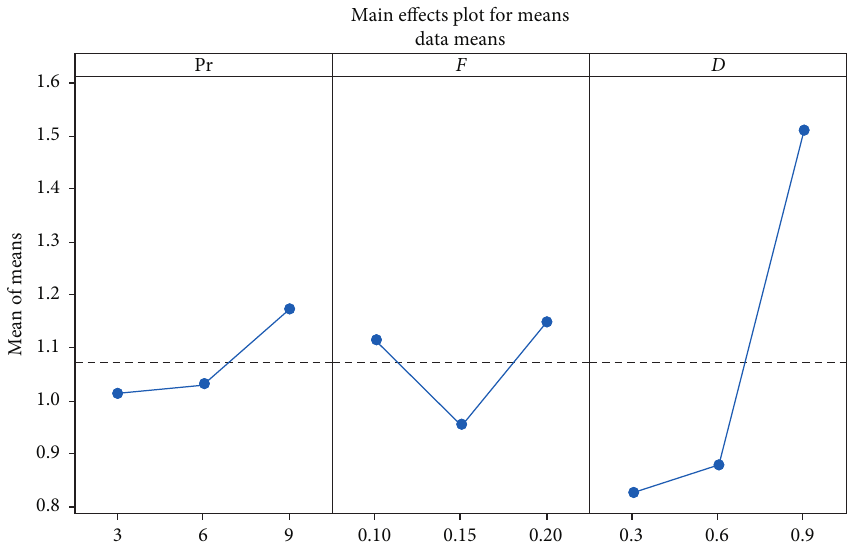
Figure 3: Mean-based important effect diagram for wear on the tool; in the X -axis, Pr denotes pressure of cutting fluid (bar), F denotes feed (mm/rev), and D denotes depth of cut (mm).